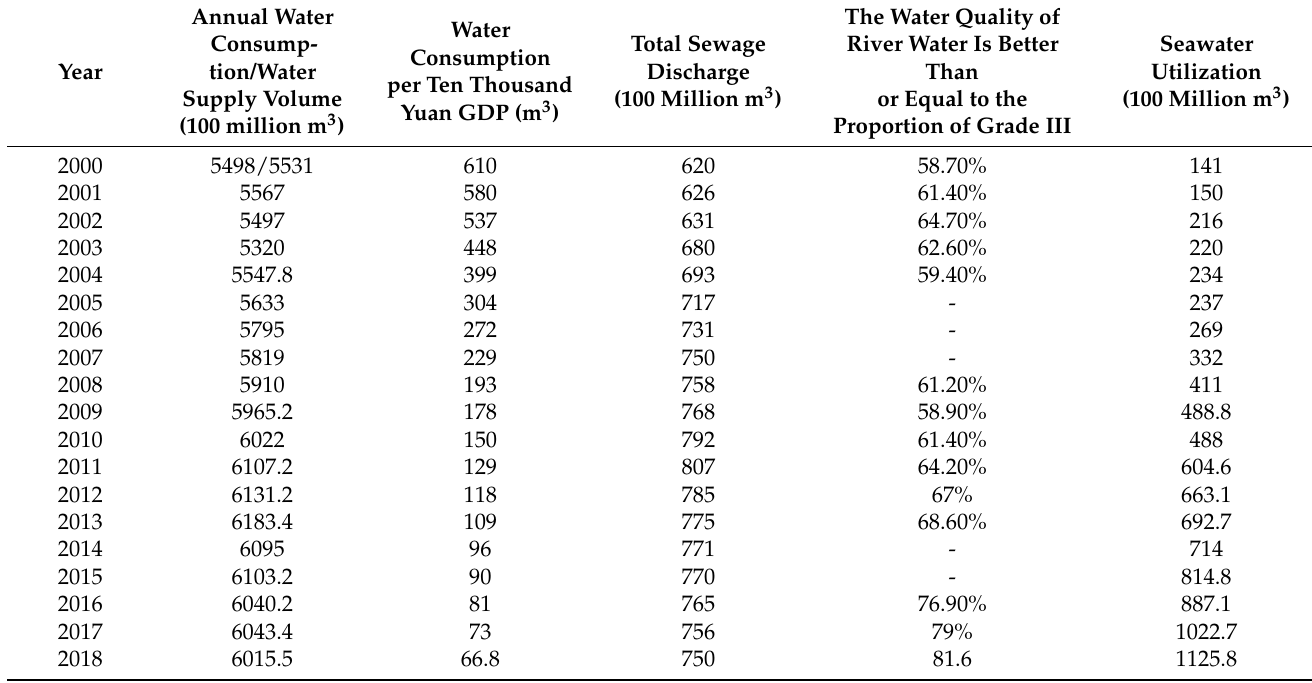
Table 1. Water resources utilization from 2000 to